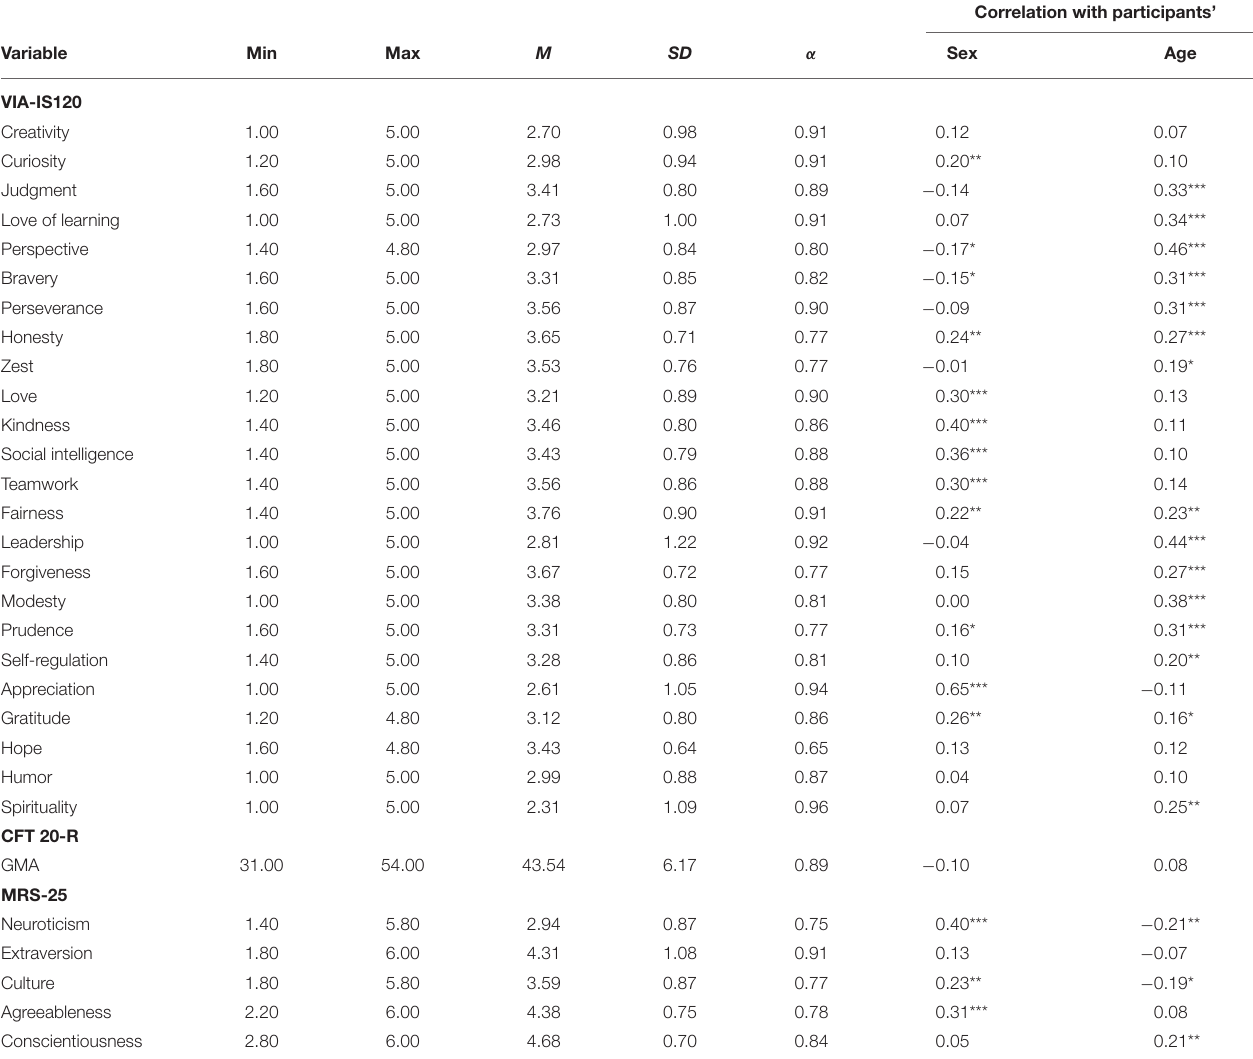
Correlation with